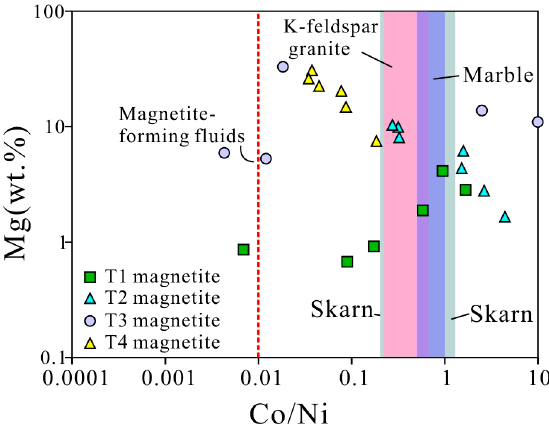
Figure 9. Binary diagrams of Mg (wt %) vs. Co/Ni for the Huanggangliang magnetite from the different ore types.